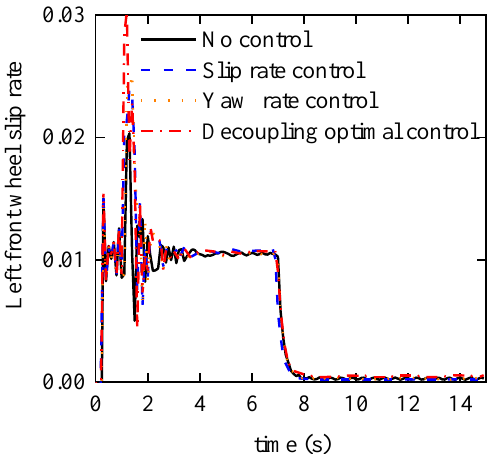
Figure 12. Left front wheel slip rate.